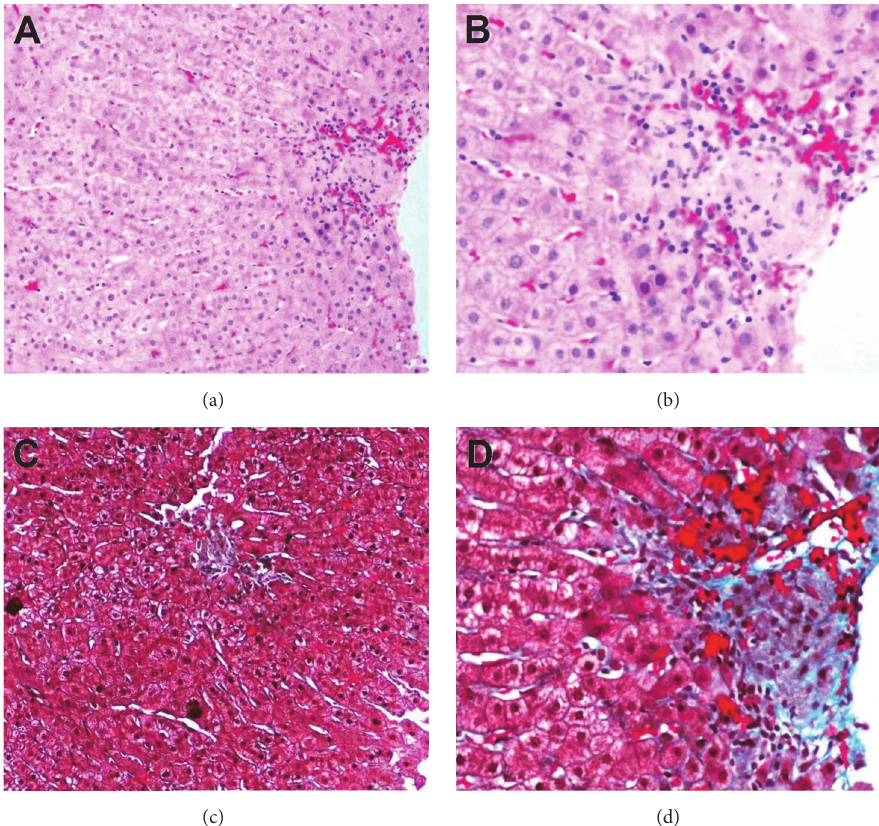
Figure 2: The portal tracts either contain scattered lymphocytes or are entirely devoid of inflammation. In the perivenular areas, Kupffer cells containing ceroid pigments indicative of prior cellular injury and cell turnover are noted. Scattered lymphocytes are also seen in the perivenular zone. Small aggregates of histocytes, “microgranulomata,” are identified in the hepatic lobule and in the perivenular region. (a) and (b) 10x and 20x H&E stain; (c) and (d) 10x and 20x trichrome